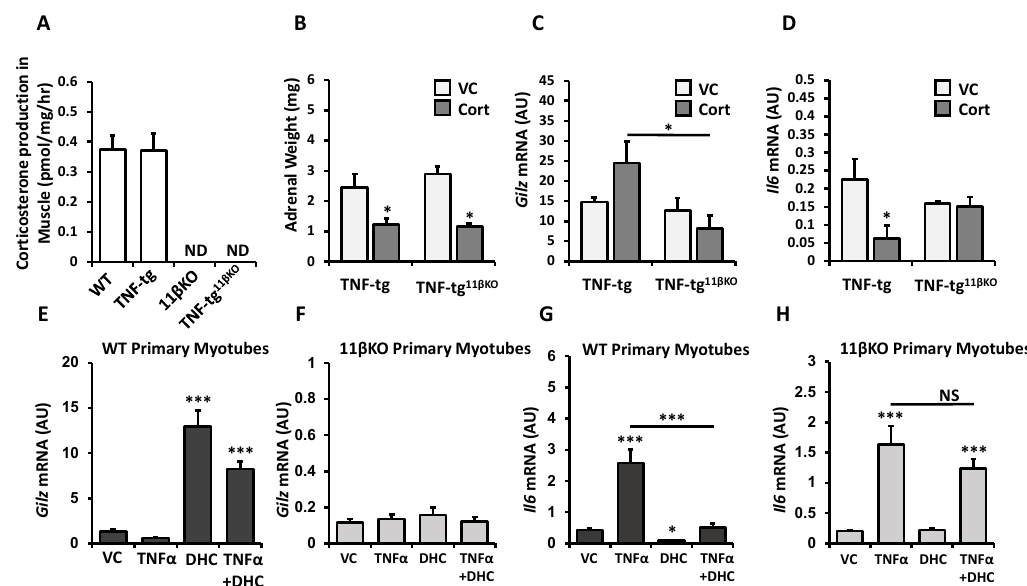
Figure 2. ( A ) Corticosterone production (pmol/mg/hour) determined by scanning thin layer chromatography in ex vivo tibialis anterior muscle biopsy isolated from wild type (WT), TNF-transgenic (TNF-tg), 11 β -HSD1 knock out (11 β KO) and TNF-tg 11 β KO animals. ( B ) Adrenal weights and gene expression (AU) of ( C ) Gilz and ( D ) Il6 determined by RT qPCR in muscle homogenates from TNF-tg and TNF-tg 11 β KO animals receiving either vehicle or corticosterone (100 µ g/mL) in the drinking water for 3 weeks. Gene expression (AU) of ( E , F ) Gilz and ( G , H ) Il6 in primary murine muscle cultures from WT or single mutant 11 β KO animals treated with recombinant TNF α and/or dehydrocorticosterone (DHC) determined by RT qPCR. Values are expressed as mean ± SE, n = 6 per group for animal experiments and n = 3 per group for primary culture. Statistical significance was determined using two-way analysis of variance with Tukey post hoc analysis. * p < 0.05, *** p < 0.001. NS, not significant; WT, Wild type; 11βKO, 11β-HSD1 genetic deletion; VC, Vehicle Control; Cort, Corticosterone; DHC, Dehydrocorticosterone; ND, not detectable.